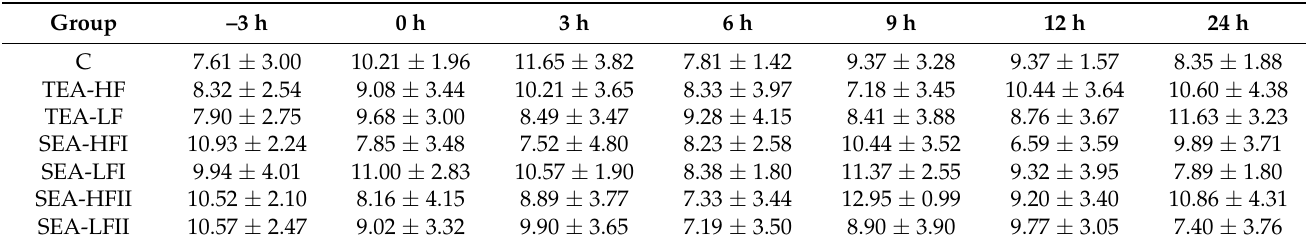
Table 3. Effects of different treatment methods on CK-MB activity at different time points ( U/L, n = 6 ). Group